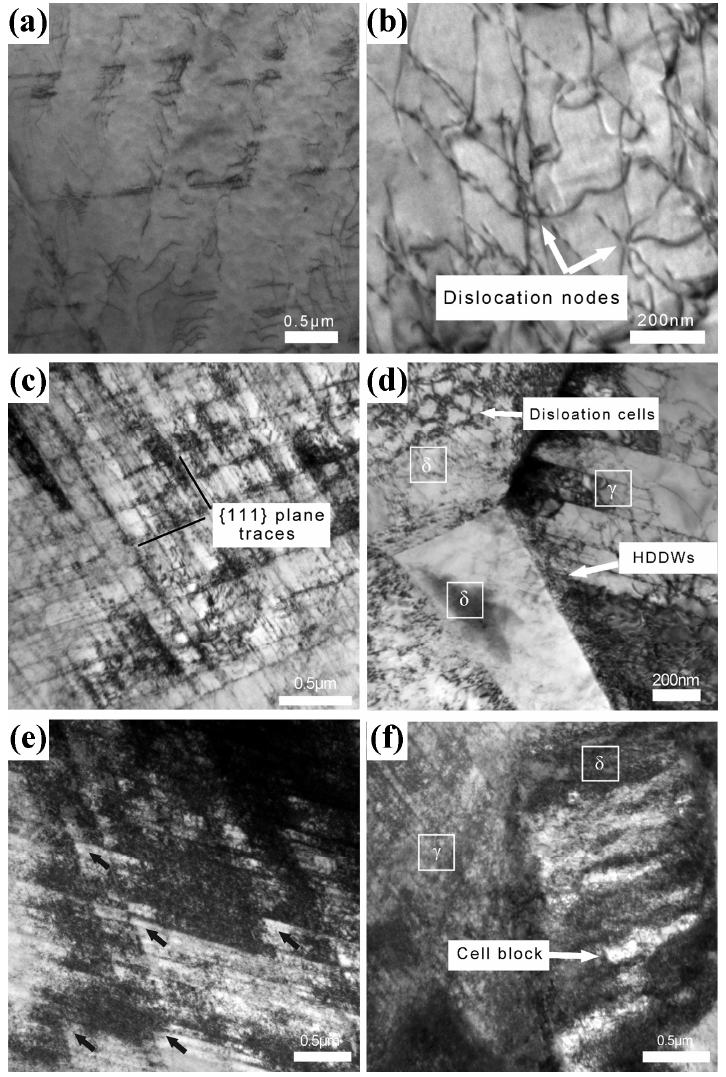
Figure 4. Dislocation substructure evolution within ( a , c , e ) austenite ( γ ) and ( b , d , f ) ferrite ( δ ) in the Fe-18.1Mn-9.6Al-0.65C steel at different strains. ( a , b ) ε = 0.02: ( a ) planar dislocation arrays, ( b ) dislocation nodes, ( c ) Taylor lattices ( ε = 0.18), ( d ) dislocation cells ( ε = 0.10), ( e , f ) ε = 0.36: ( e ) microbands intersections, ( f ) cell block [77]. (Reproduced with permission from [77]. Copyright 2015 Elsevier).